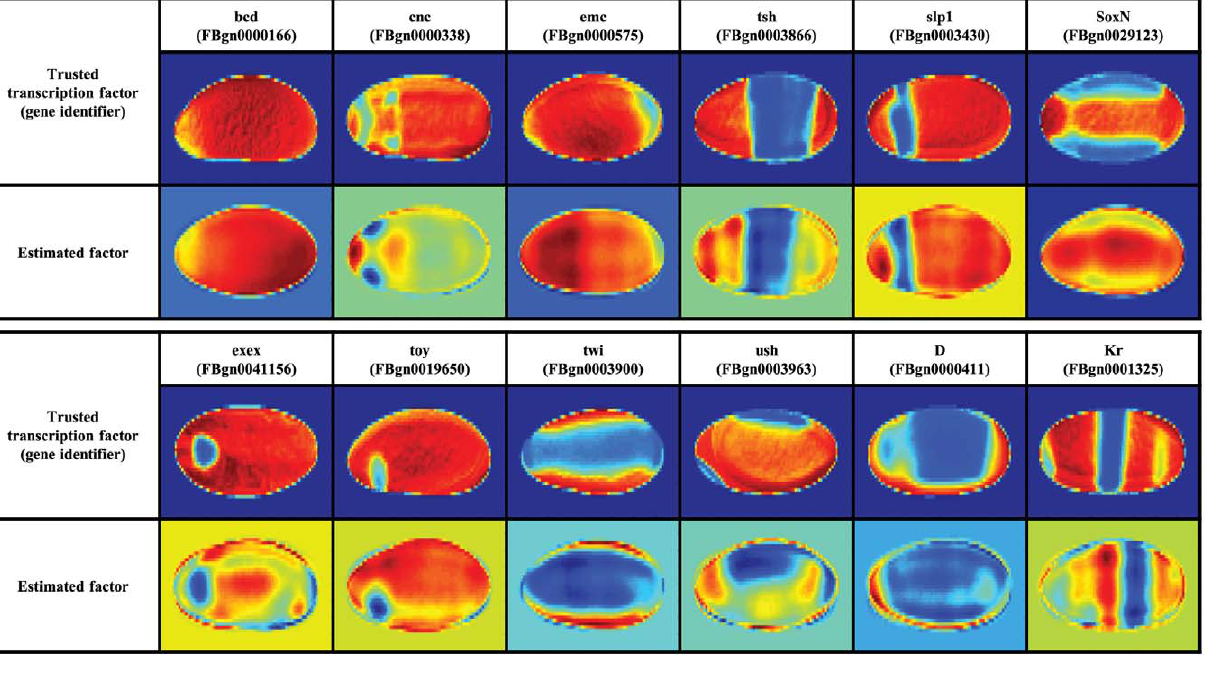
PLoS Computational Biology |